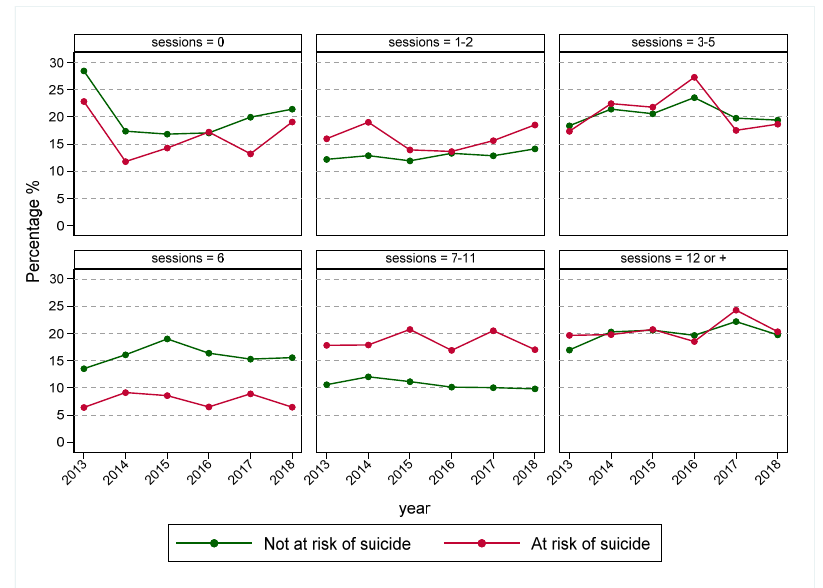
ceived services on the same day.